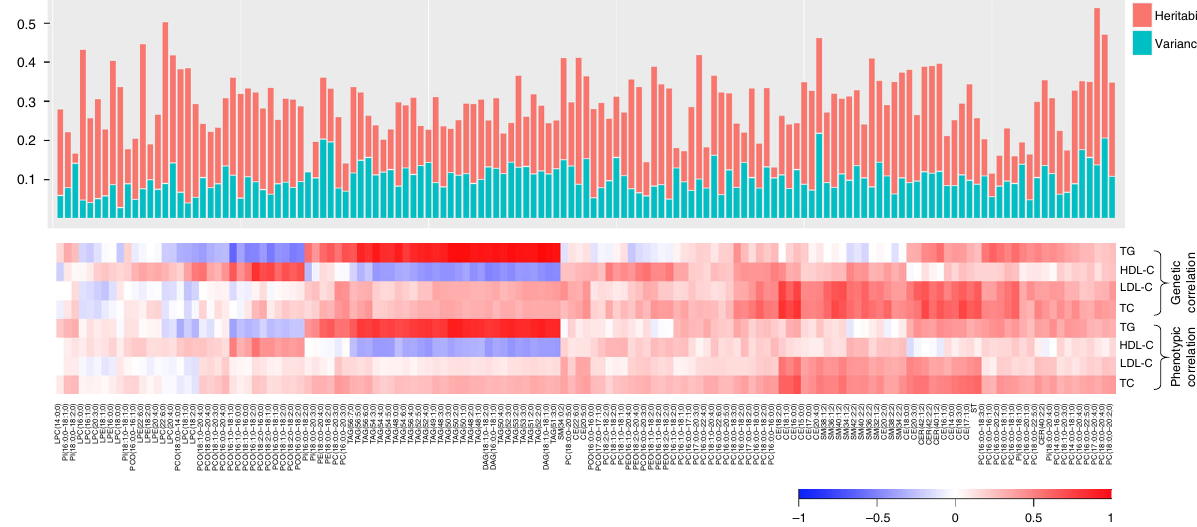
Fig. 3 Lipidomic pro fi les capture information beyond traditional lipids. The genetic and phenotypic correlations between traditional lipids and molecular lipid species are shown in lower panel. The bar plot in the upper panel shows the heritability estimates of each lipid species (red bars) and the variance explained by all the known loci together (green bars). The lipid species are ordered based on the hierarchical clustering showing the correlations between the lipid species and traditional lipids. TC total cholesterol, TG triglycerides